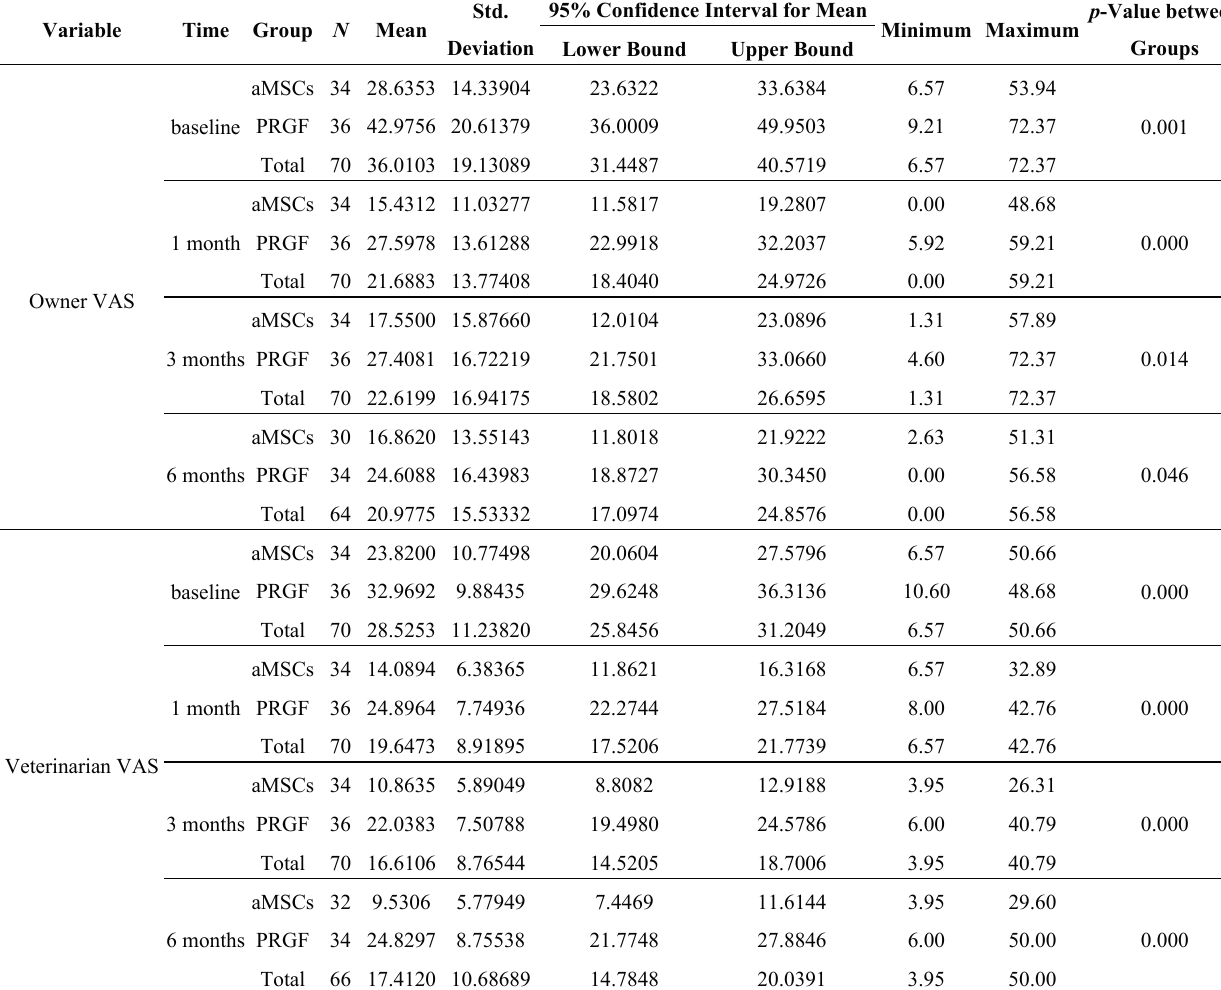
Table 2. The mean VAS (±SD) assessed by the dog owners and by the investigator at each time point. For statistical purposes, the Kruskal Wallis Test was applied (Spss Statistics for MAC, version 20, IBM, Madrid, Spain). Differences between groups are shown as p -value between groups. p < 0.05 is considered statistically